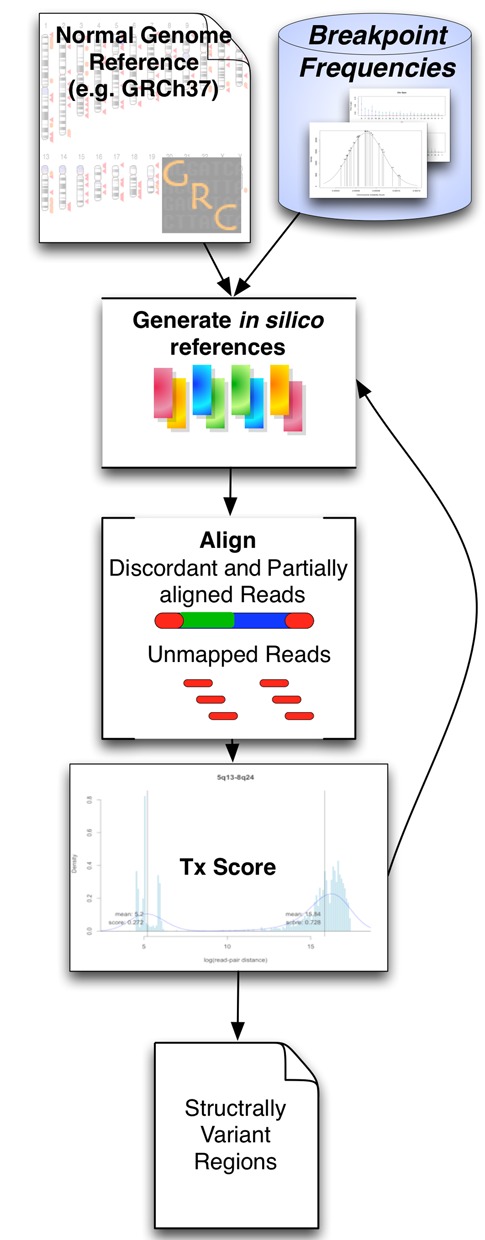
The general workflow of this method takes prior knowledge of the likelihood of an aberration at points in the chromosome to generate a new in silico reference. This is then used to align the discordant and unmapped reads from a previously aligned sample, scored and clustered to identify the best scoring regions.